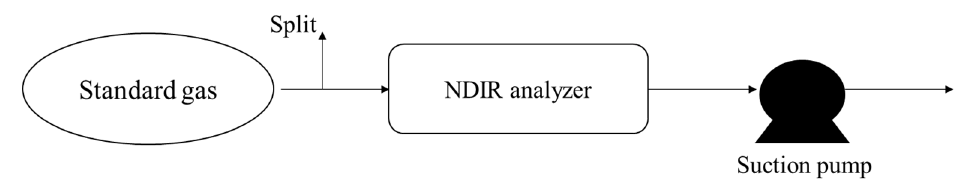
Figure 2. Experimental setup for a CO 2 nondispersive infrared (NDIR) analyzer.